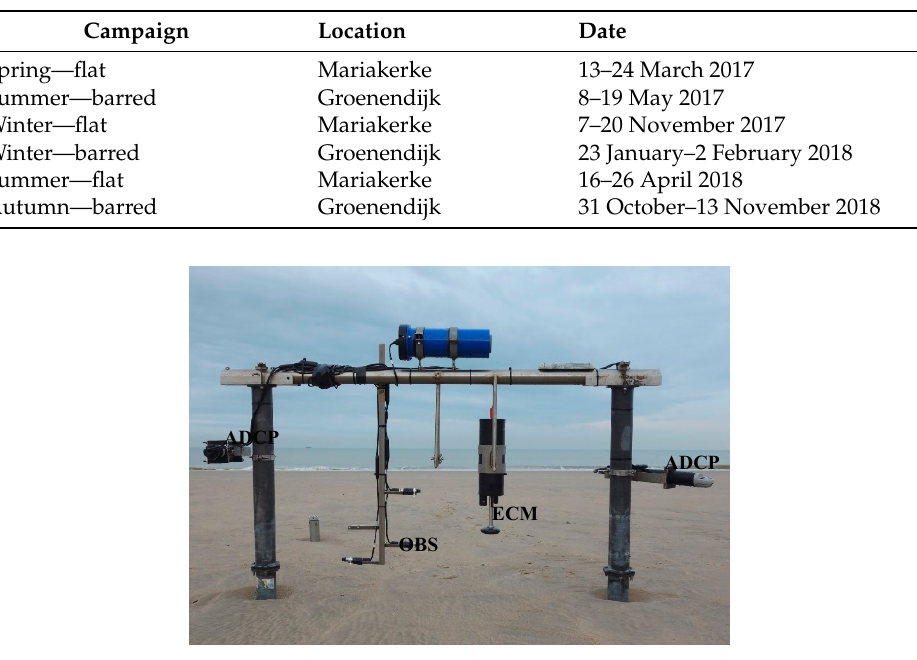
Table 1. Overview of the intertidal measuring campaigns. (Note that ‘flat’ here corresponds to the developed site Mariakerke and ‘barred’ corresponds to the natural site Groenendijk).